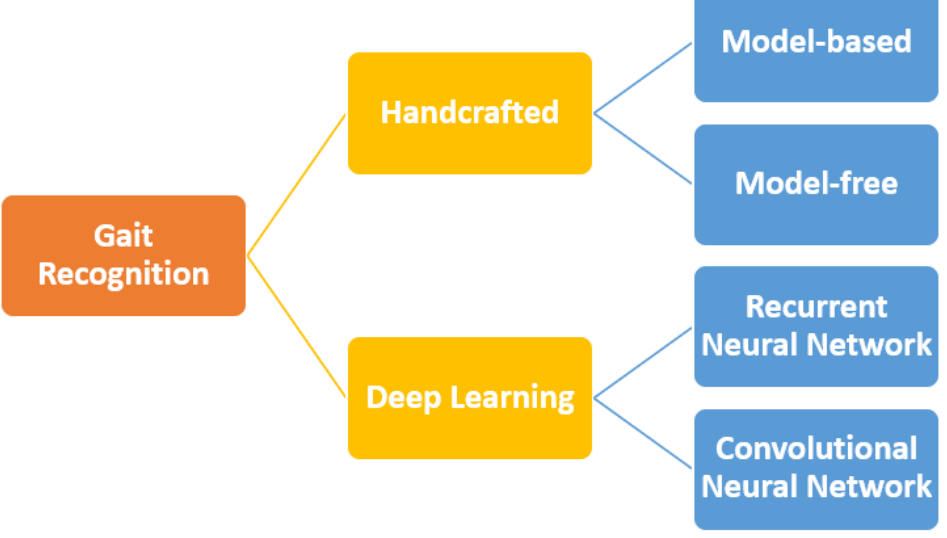
Figure 3. The categorization of gait recognition